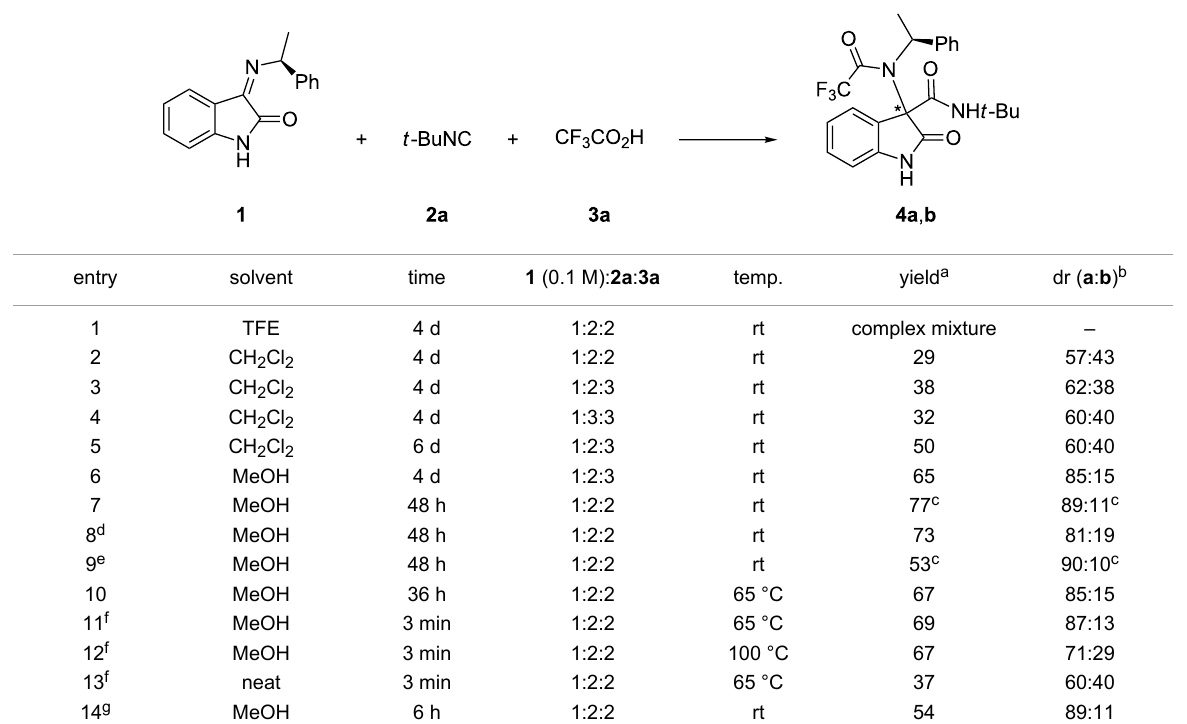
scheme used (Figure 2). The stereochemical assignment S was attributed on the basis of the known ( S )-configuration of the phenyl ethylamine residue.